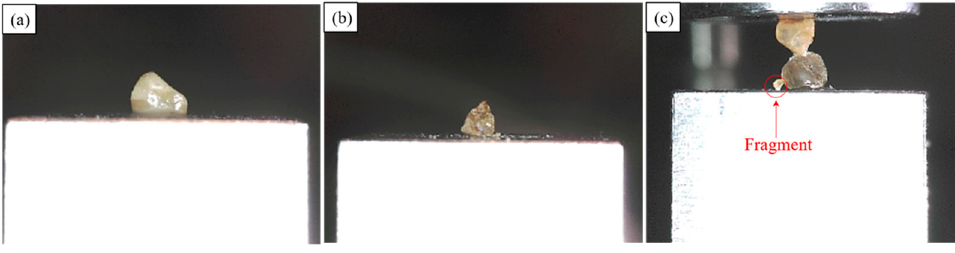
Figure 14. Representative examples of the different failure modes ( a ) conservative, ( b ) destructive, and ( c ) fragmentary.